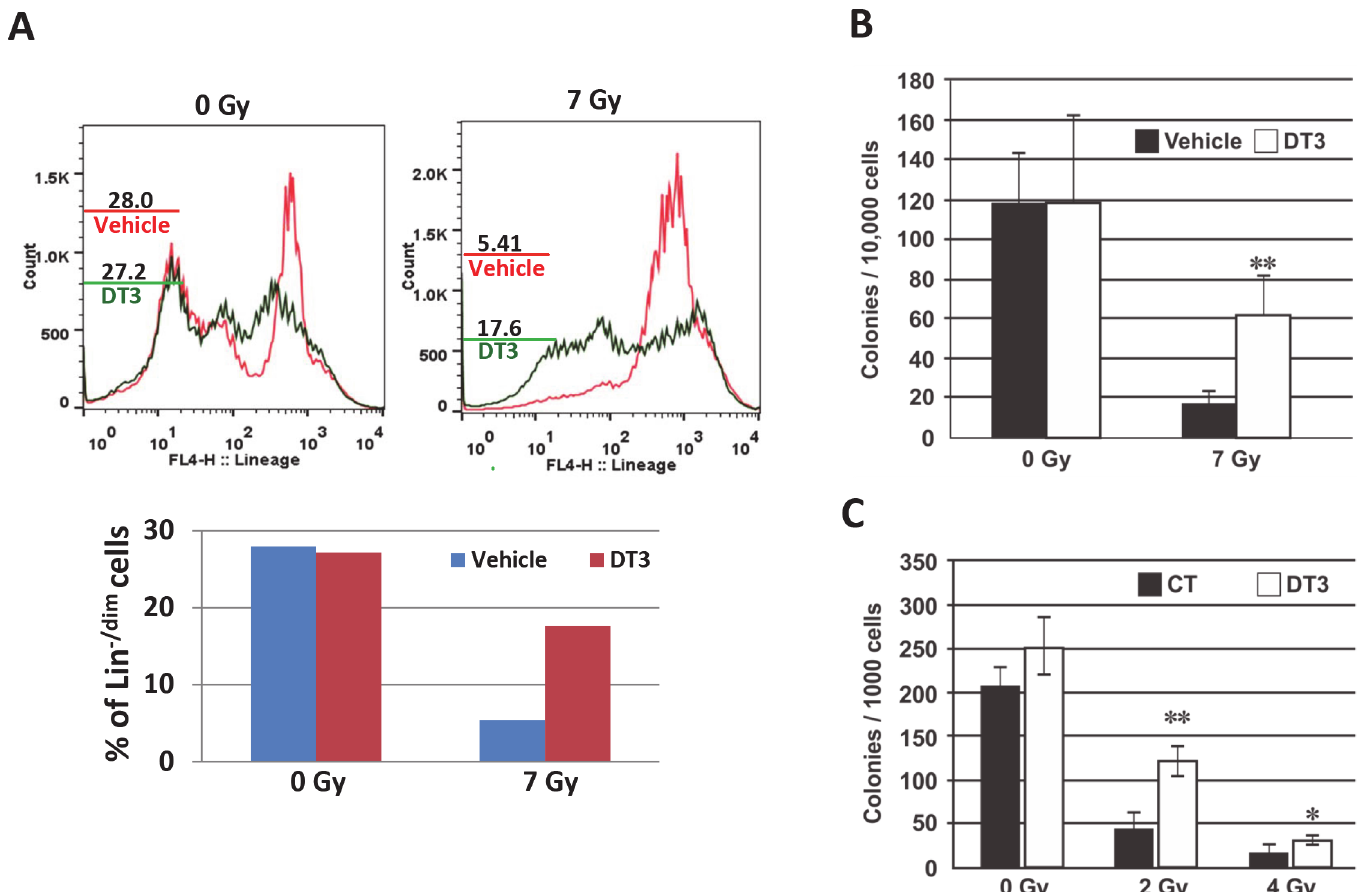
Fig 2. DT3 protected mouse and human hematopoietic stem and progenitor cells. Mouse bone marrow (BM) cells were collected from femurs and humeri 24 h after irradiation. (A) Flow cytometric analysis shows frequencies of live lineage-negative and lineage-dim (Lin-/dim) stem and progenitor cells in vehicle- or DT3-treated and sham or 7 Gy TBI mouse BM. Samples were pooled from 6 mice in the same group. Results were from one representative experiment of two independent experiments. (B) Clonogenicity of mouse BM cells was quantified in standard semisolid cultures in triplicate. Colonies were counted 10 days later. Results were from one representative experiment of two independent experiments (N = 6 mice /point/experiment). Means ± SD. ** , p < 0.01, DT3-treated vs. vehicle-treated controls. (C) Clonogenicity of human CD34+ cells was quantified in standard semisolid cultures after 2 Gy or 4 Gy irradiation in triplicate. Colonies were counted 14 days later. Results were from one representative experiment of three independent experiments. Means ± SD. * , p < 0.05, ** , p < 0.01, DT3-treated vs. vehicle-treated controls.